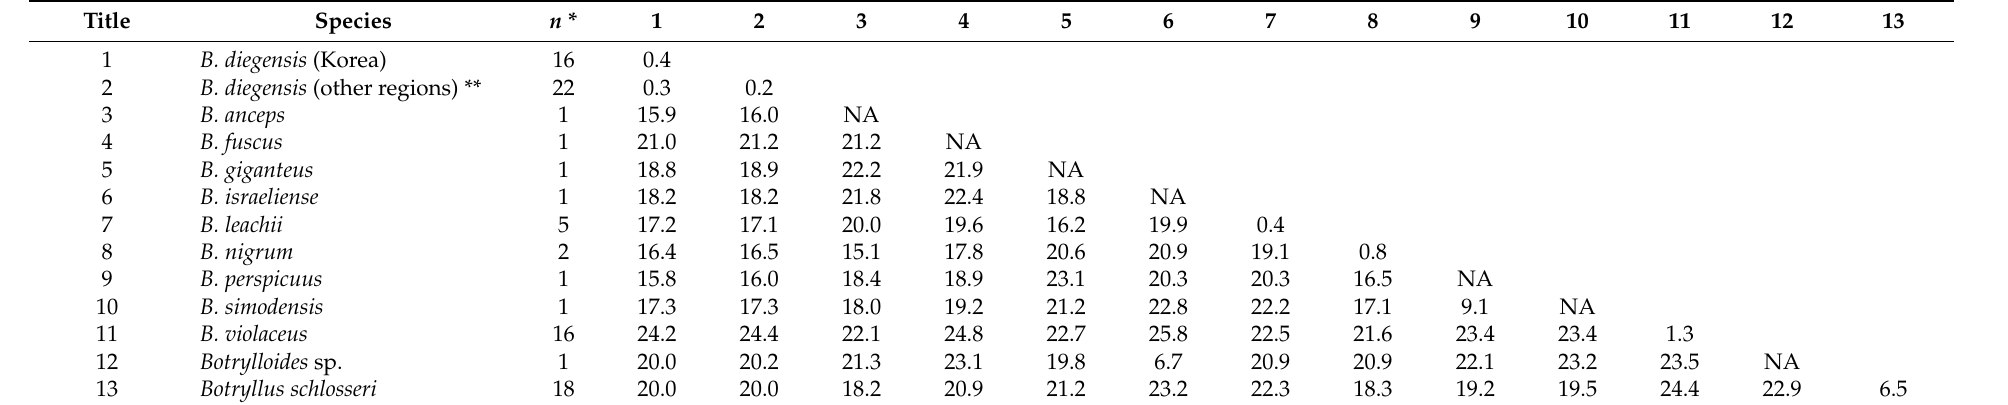
Table 3. Pairwise distances (%) for 11 species of Botrylloides and Botryllus schlosseri obtained from South Korea and GenBank based on the Kimura 2-parameter model.